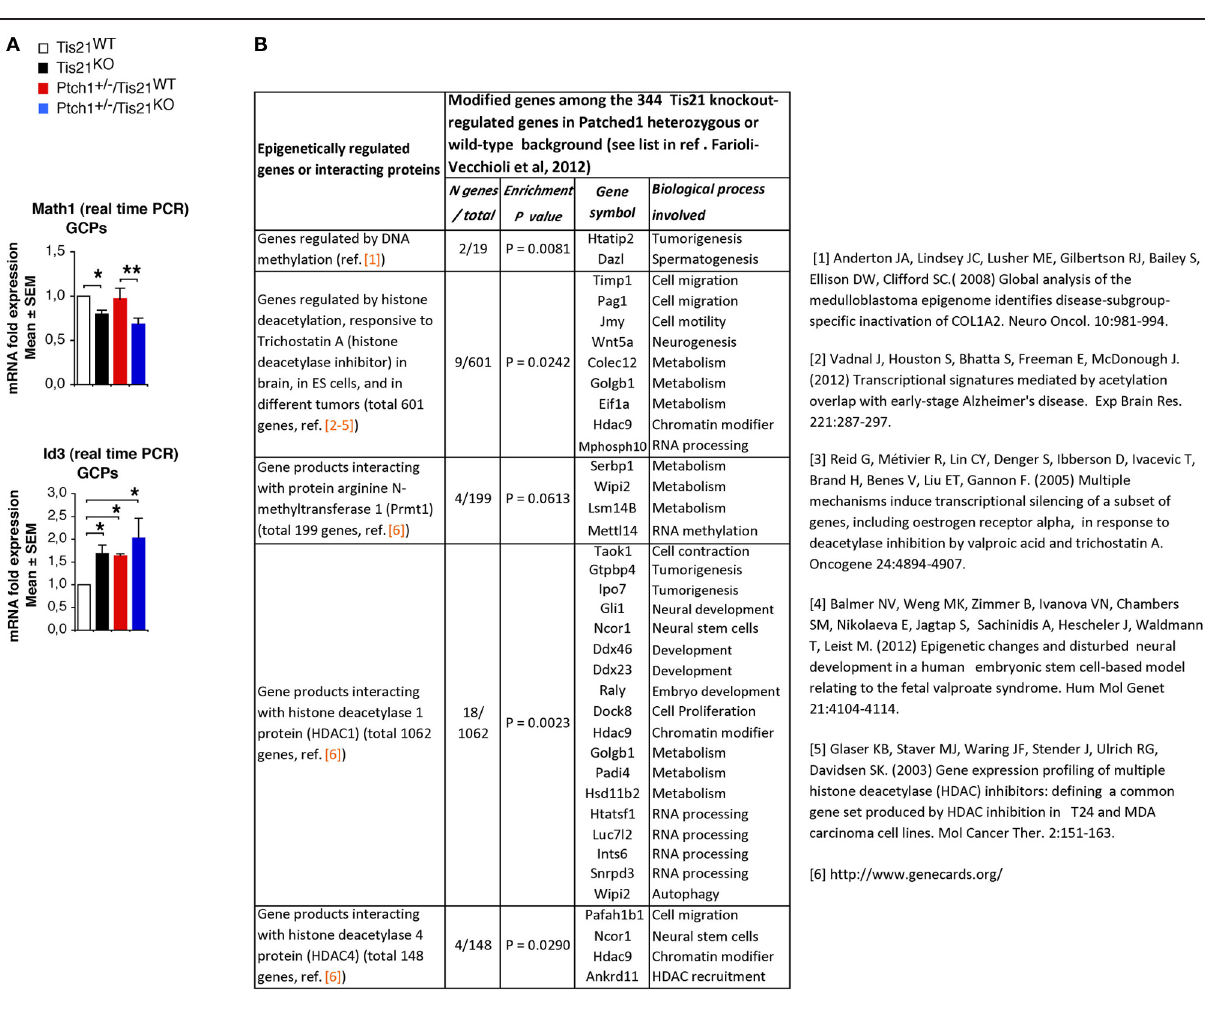
FIGURE A1 | (A) Math1 and Id3 mRNA expression values by real time PCR analysis performed in GCPs from 7-days-old mice of the four genotypes indicated. Math1 mRNA levels are reduced in GCPs of Tis21 knockout mice, either in a Patched1 wild-type